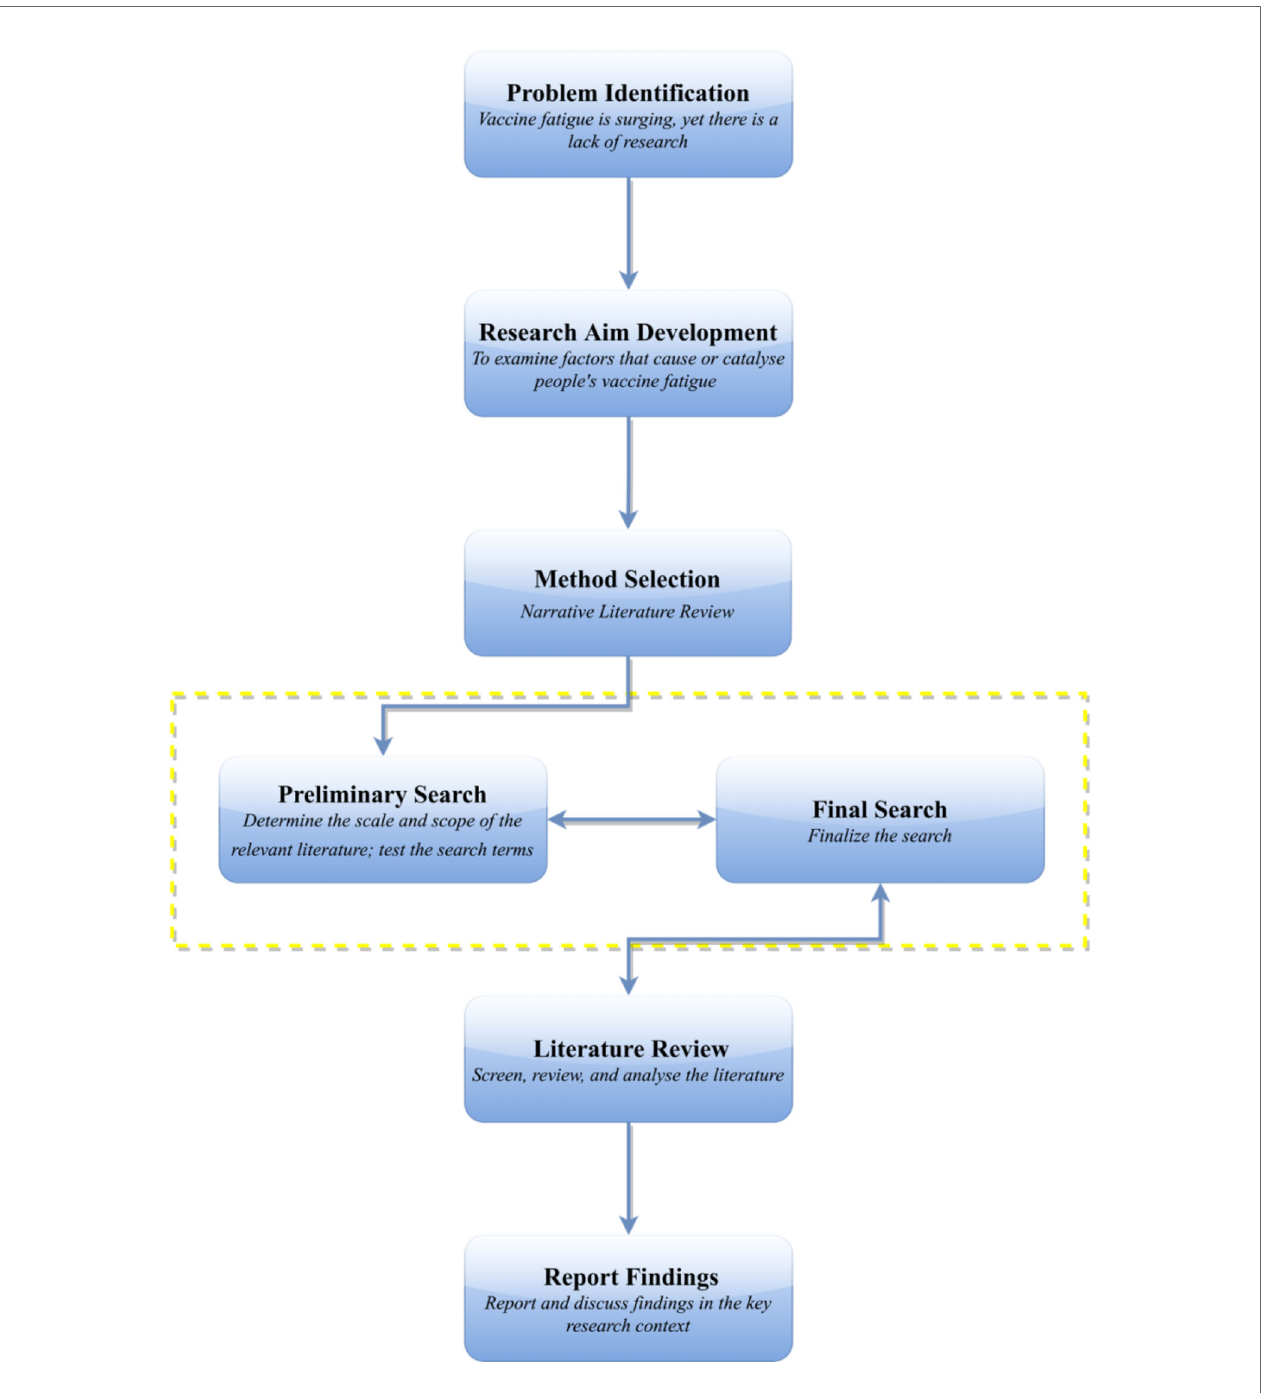
FIGURE 1 | The research process in a fl